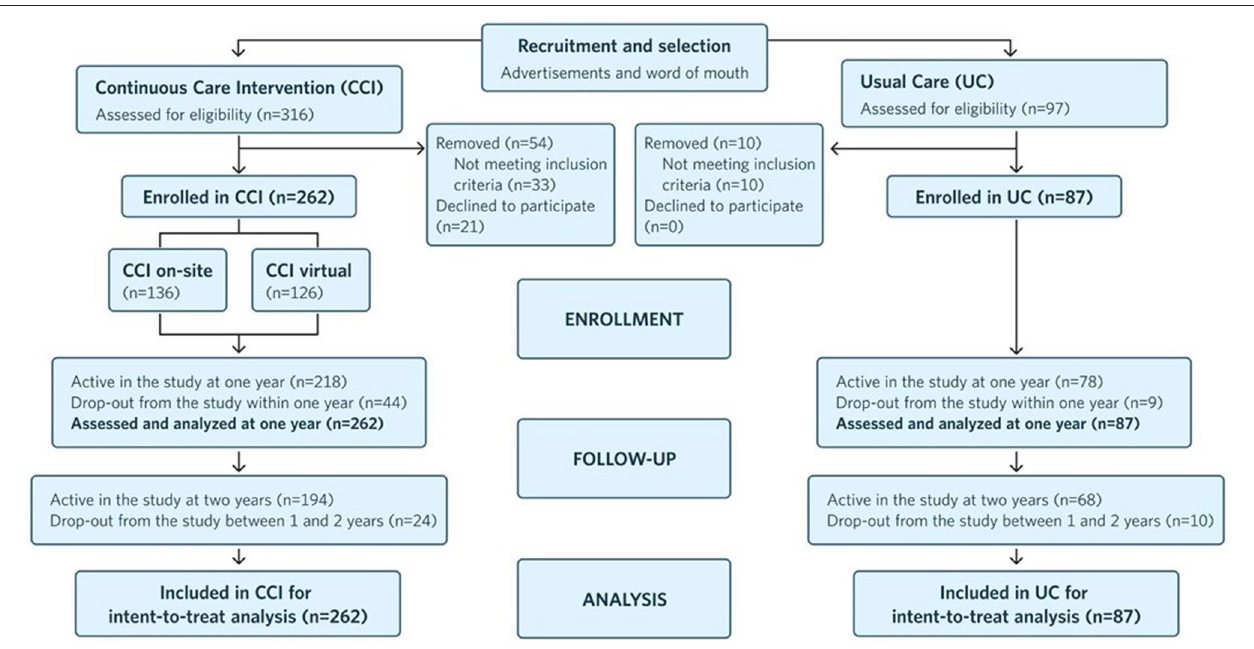
FIGURE 1 | Flow chart of participants in each stage of the study from recruitment to 2 years post-enrollment and